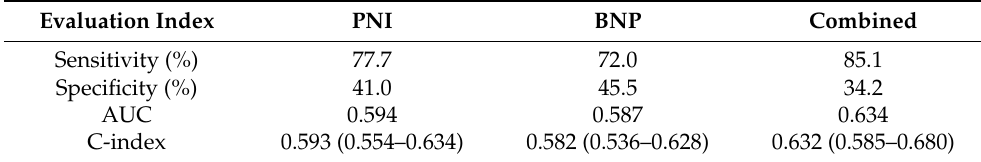
Table 4. Diagnostic evaluation of PNI and BNP in OS of Patients with heart